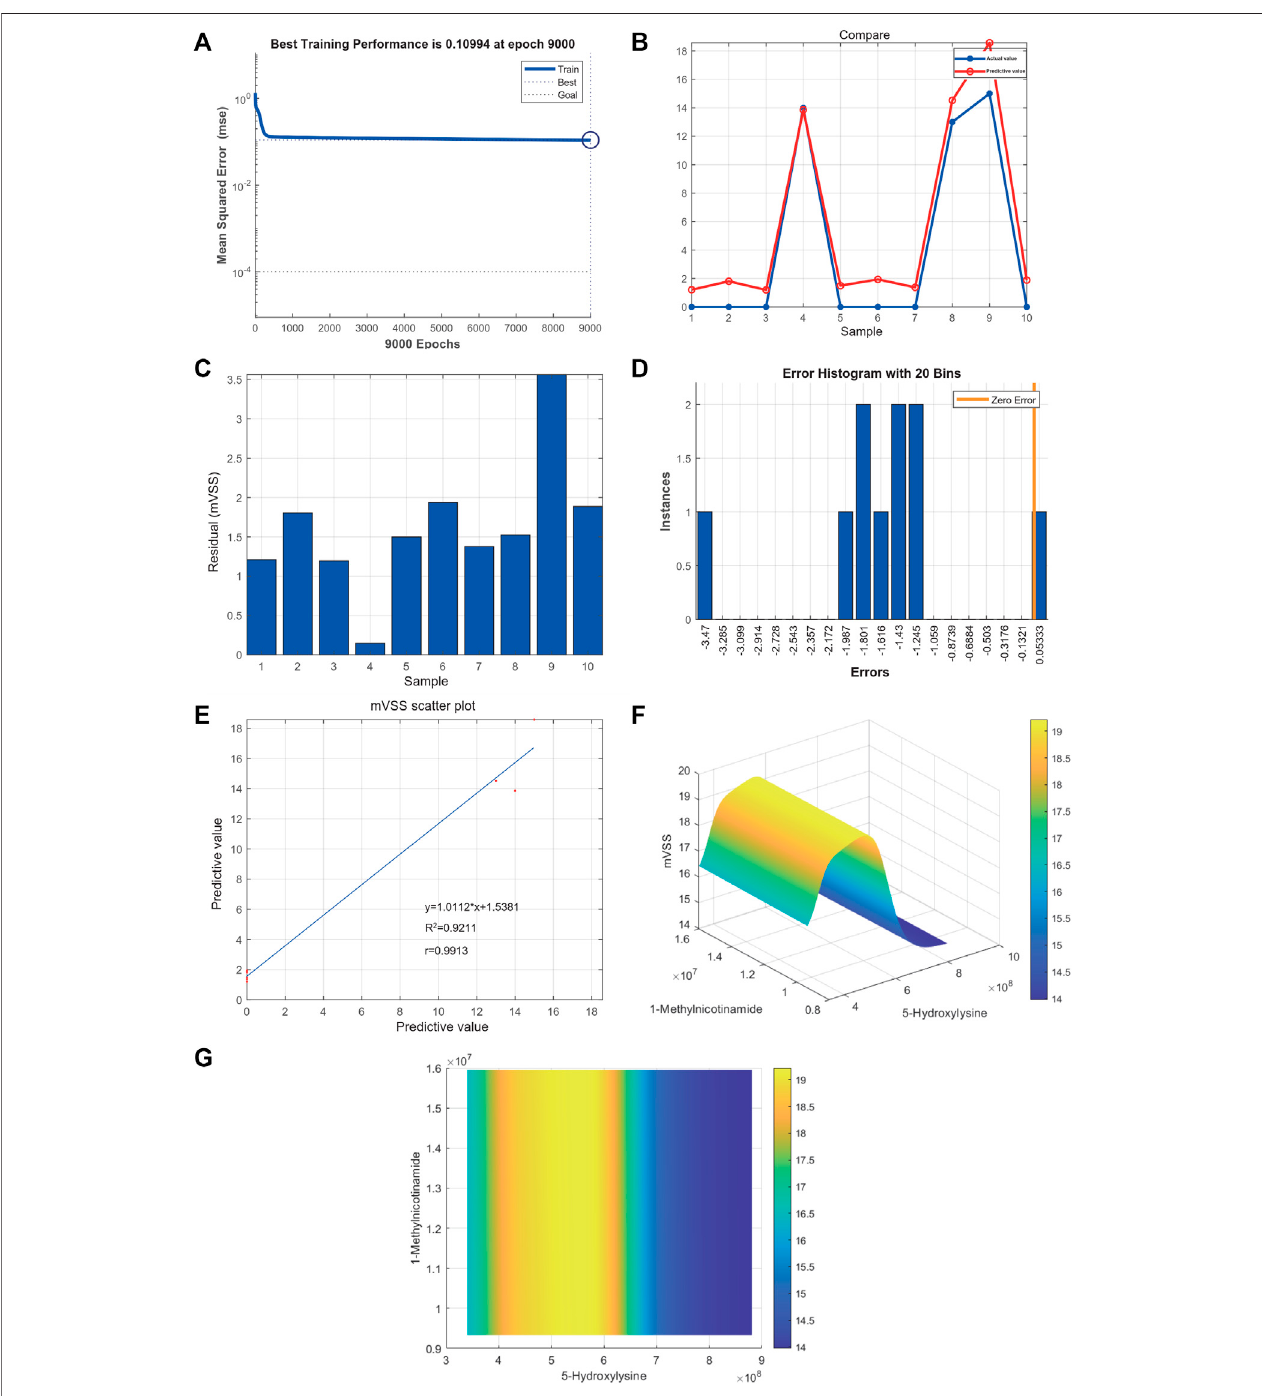
FIGURE8|(A) Neuralnetworkmodel forthe prediction ofkeloid severity. (A) Thebest training performancewas0.10994at epoch 9,000. (B) Thepredictive value of the data was veri fi ed against the actual value. (C) Absolute error diagram between the predicted value and the actual value of the data. (D) Error distribution map betweenthepredictedvalueandtheactualvalueofthedata. (E) CorrelationscatterplotofmVSS.y (cid:1) 1.0112*x+1.5381, R 2 (cid:1) 0.9211,r (cid:1) 0.9913. (F,G) High-riskwarning range of 5-hydroxylysine and 1-methylnicotinamide at the planform and three-dimensional levels.